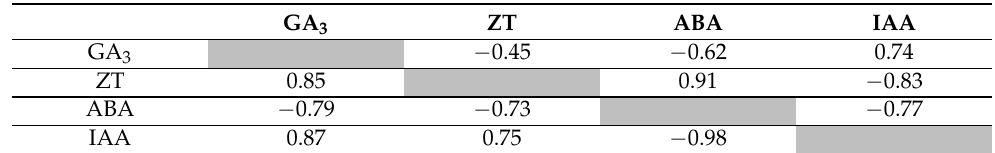
Table 2. Correlation between hormones in susceptible species (below the diagonal) and tolerant species (above the diagonal) under normal and low-temperature